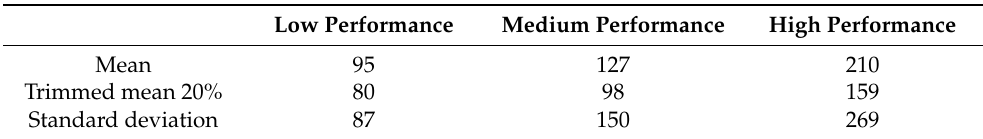
Table 1. Mean, trimmed mean and standard deviation of the dimension of open space by performance category (sqm).